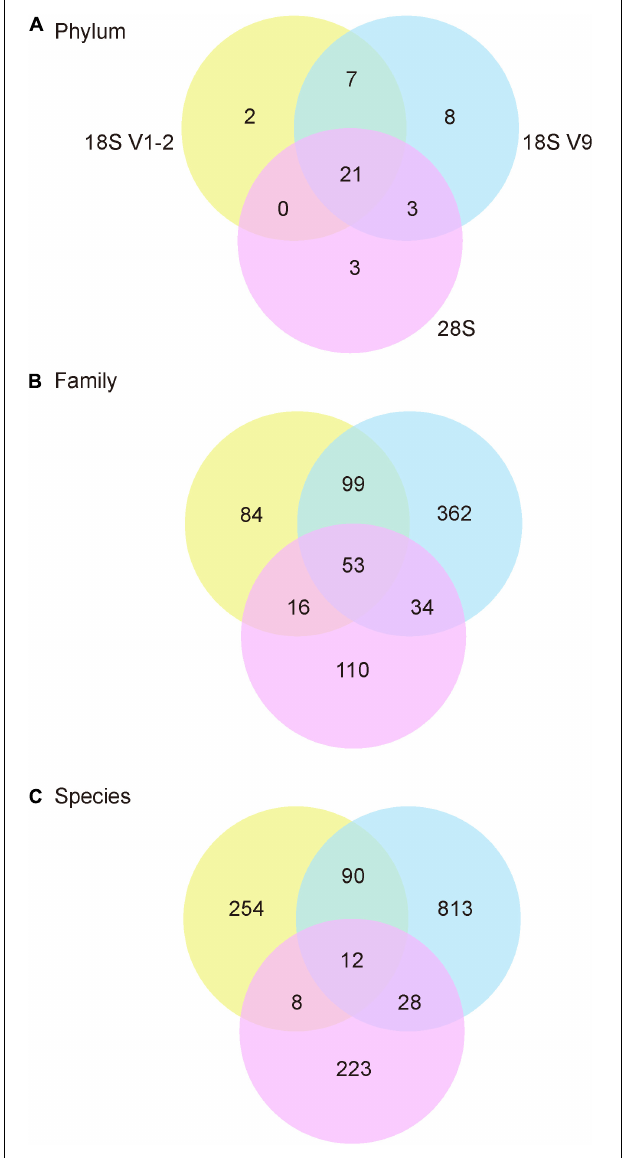
FIGURE 2 | Venn diagrams showing number of phyla (A) , families (B) , and species (C) for 28S, 18S V1-2, and 18S V9 against the NCBI nt database.